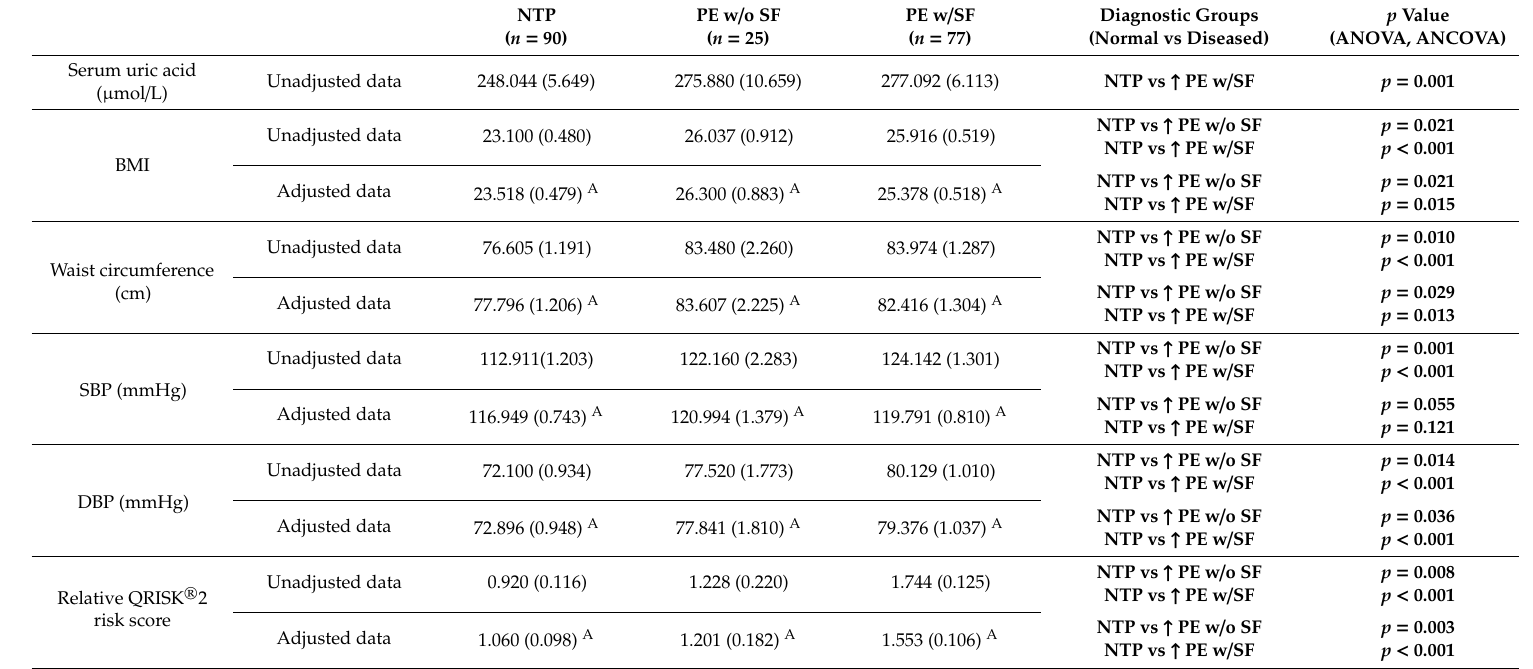
Table 4. Impact of severity of PE on maternal cardiovascular risk - overview (ANOVA and ANCOVA